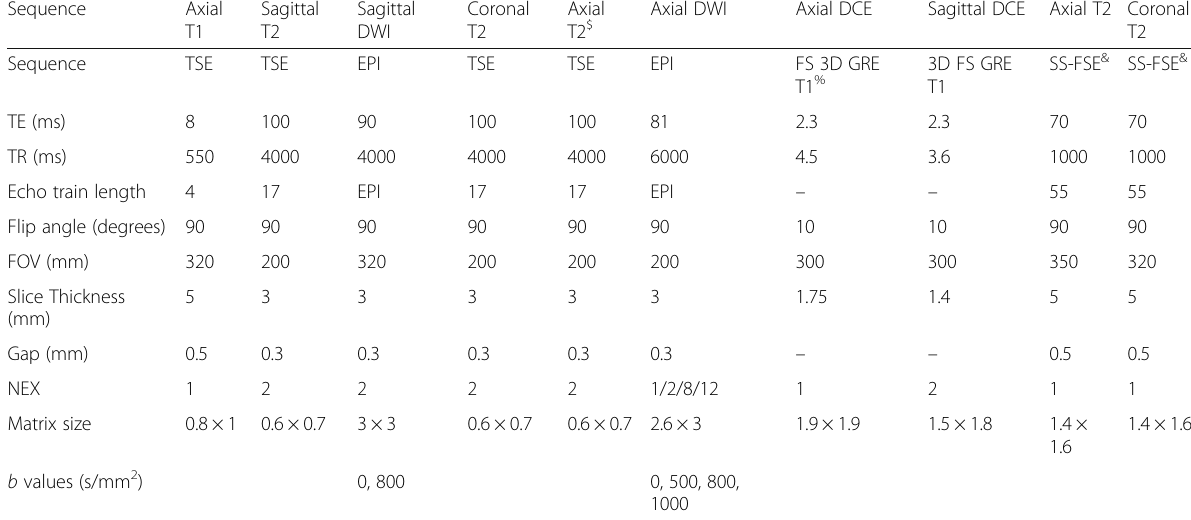
Table 3 MRI protocol for endometrial and cervical carcinoma Sequence Axial T1